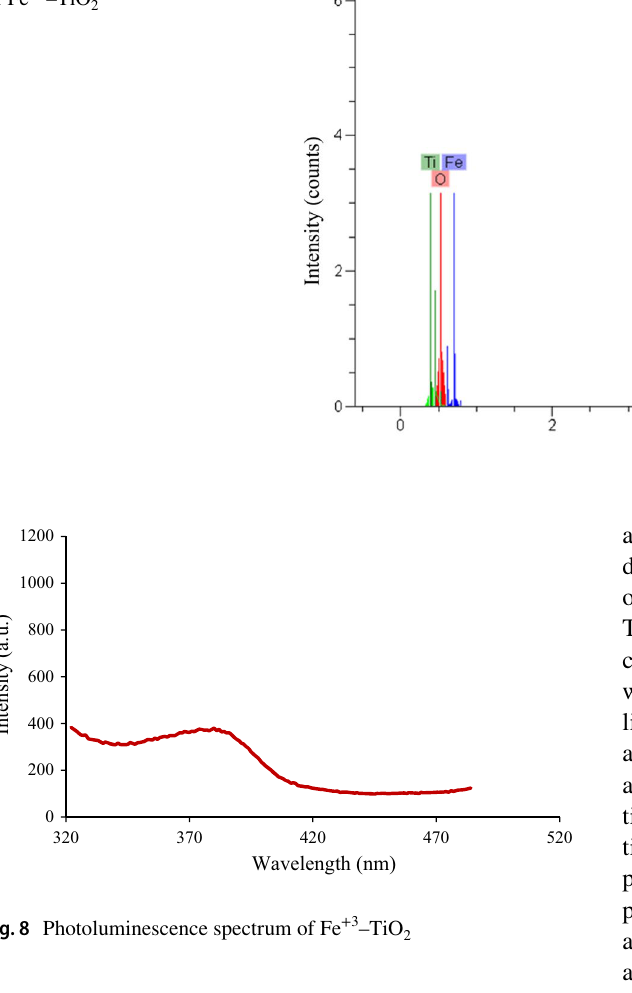
C 2 = 60 mg/L, 0 = 25